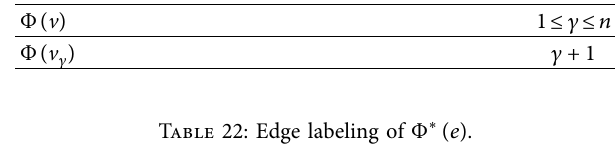
Table 21: Vertex labeling of Φ ( v ).